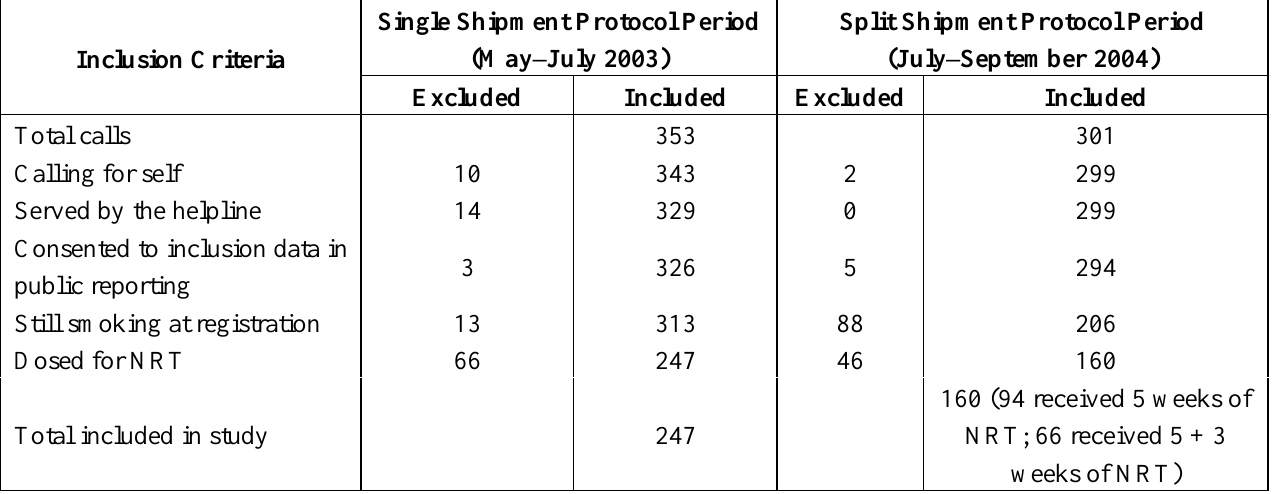
Table 1. Inclusion and Exclusion criteria by NRT protocol